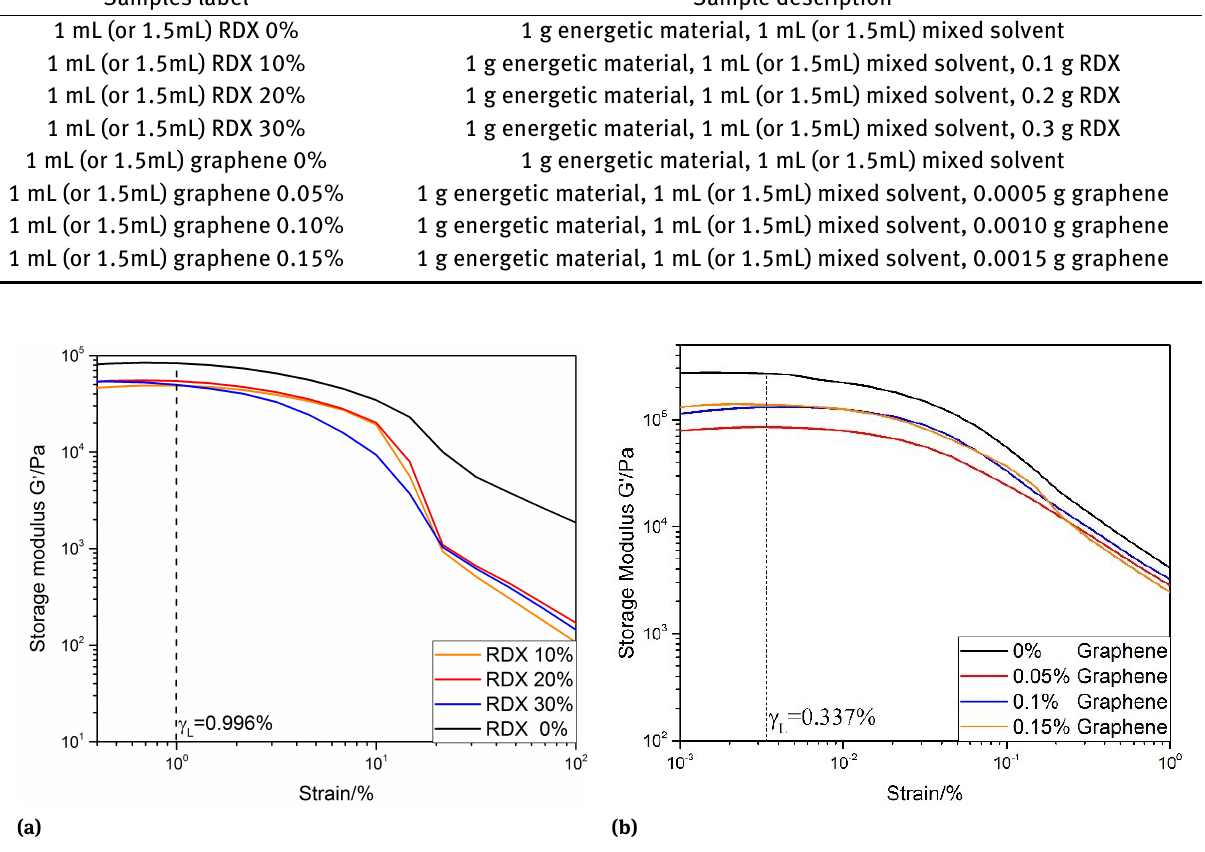
Figure 1: Storage modulus vs. strain of RDX and graphene curves at different